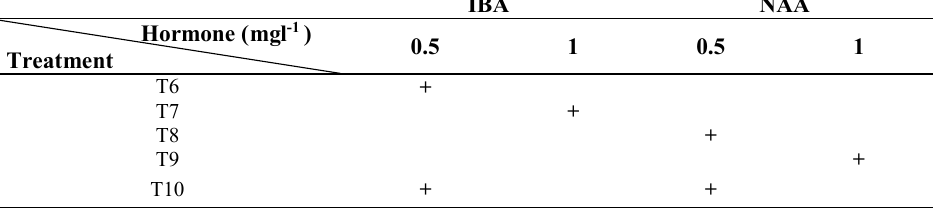
Table 2. Rooting different treatments of E. globules.